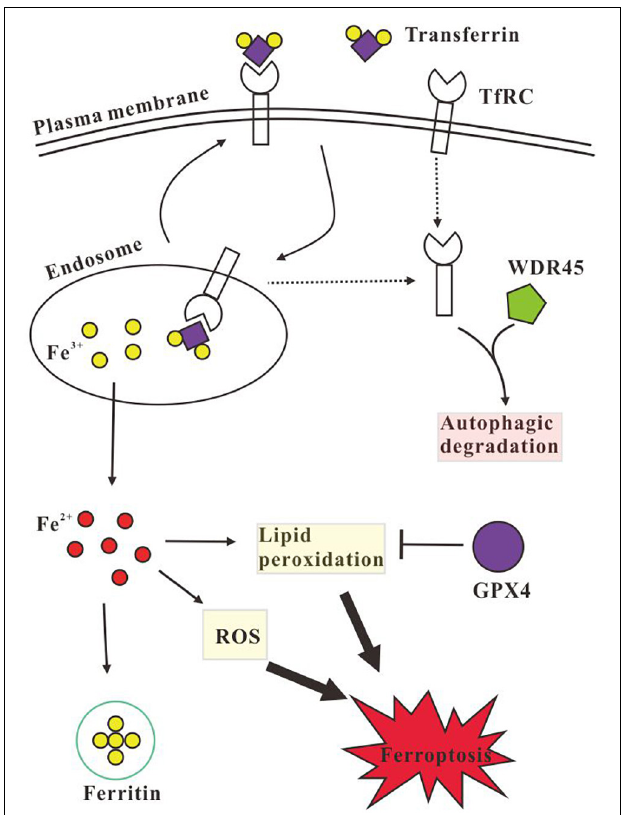
FIGURE 5 | Schematic illustration of the autophagic degradation of transferrin receptor (TfRC) regulates iron homeostasis. TfRC imports iron by binding transferrin, the Fe 3 + is released inside the endosome, and then Fe 3 + is transported to the cytoplasm and is reduced to Fe 2 + , while the TfRC is recycled back to the plasma membrane or is degraded via autophagy. Excess Fe 2 + promotes the generation of LPO and reactive oxygen species (ROS) which causes cell ferroptosis. Intracellular excess iron could be stored by ferritin and the LPO could be eliminated by glutathione peroxidase 4 (GPX4). However, WDR45 deficiency impairs autophagic degradation of TfRC and decreases the protein level of ferritin H (FTH) chain and GPX4, therefore the cellular Fe 2 + is elevated which promotes the generation of LPO and ROS and induces ferroptosis